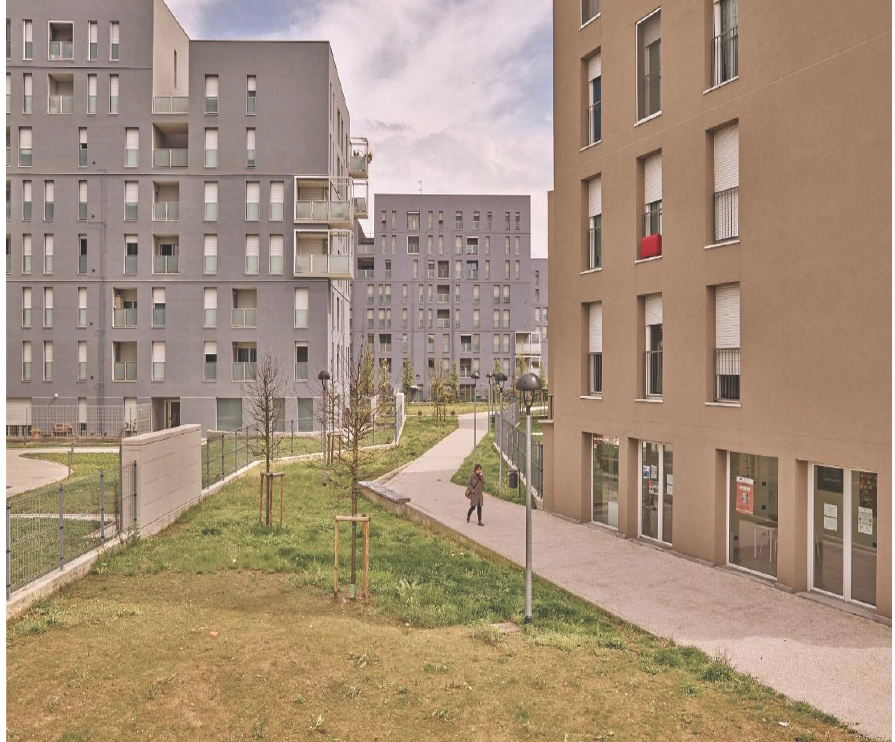
Figure 6. The ground floor spaces of WeMi Voltri (on the right) inside the social housing estate of Via Voltri‐Via di Rudini, Milan. Source: Courtesy of Giovanni